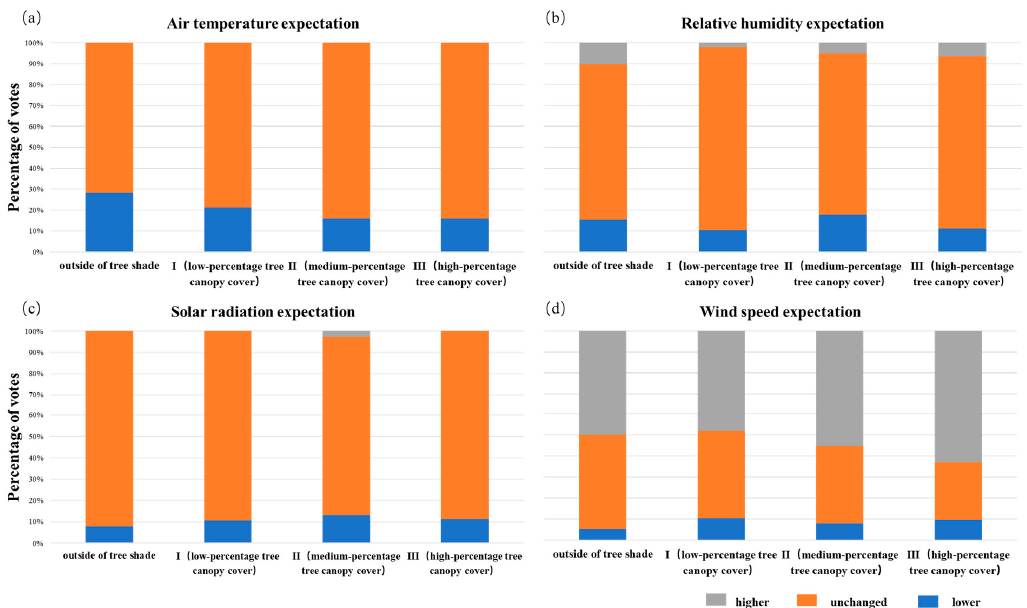
Figure 7. Microclimate expectations under different degrees of tree canopy cover when the thermal sensation vote is “neutral” (TSV = 0). ( a ) Air temperature expectation; ( b ) relative humidity expectation; ( c ) solar radiation expectation; ( d ) wind speed expectation.